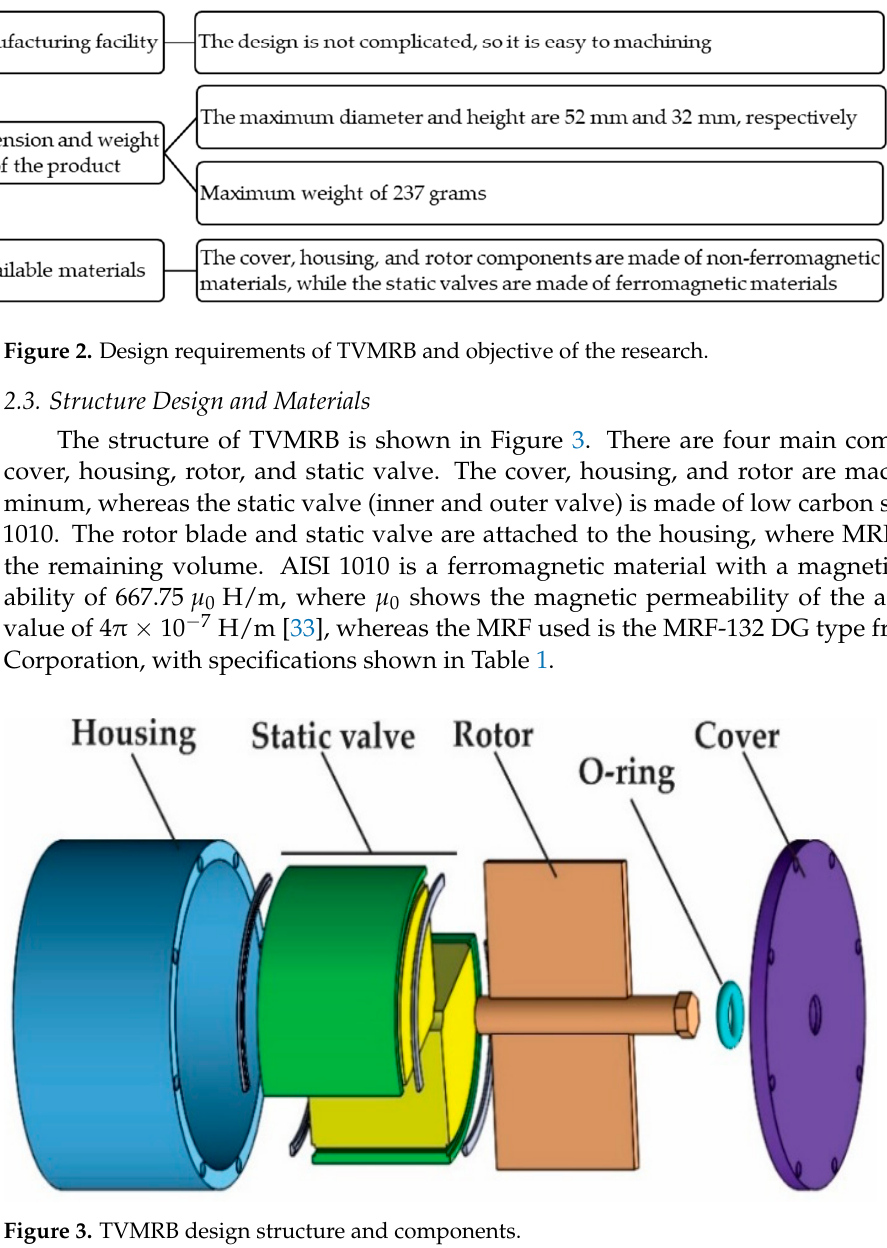
Figure 3. TVMRB design structure and components.